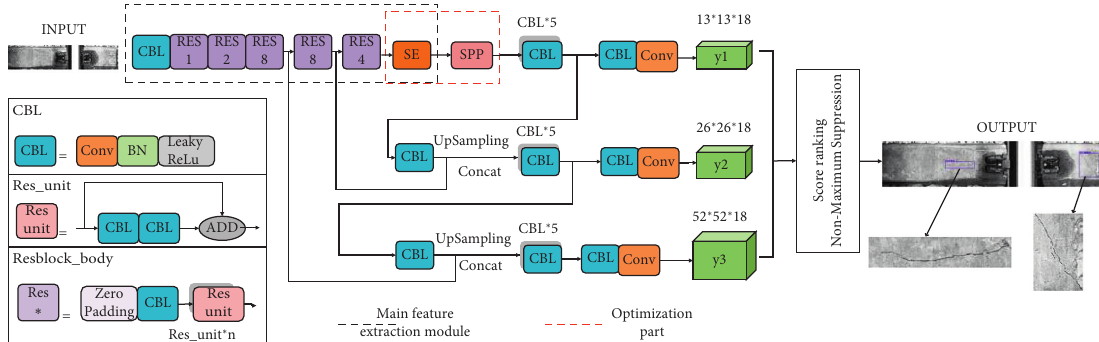
Figure 4: Improved YOLOV3 structure process